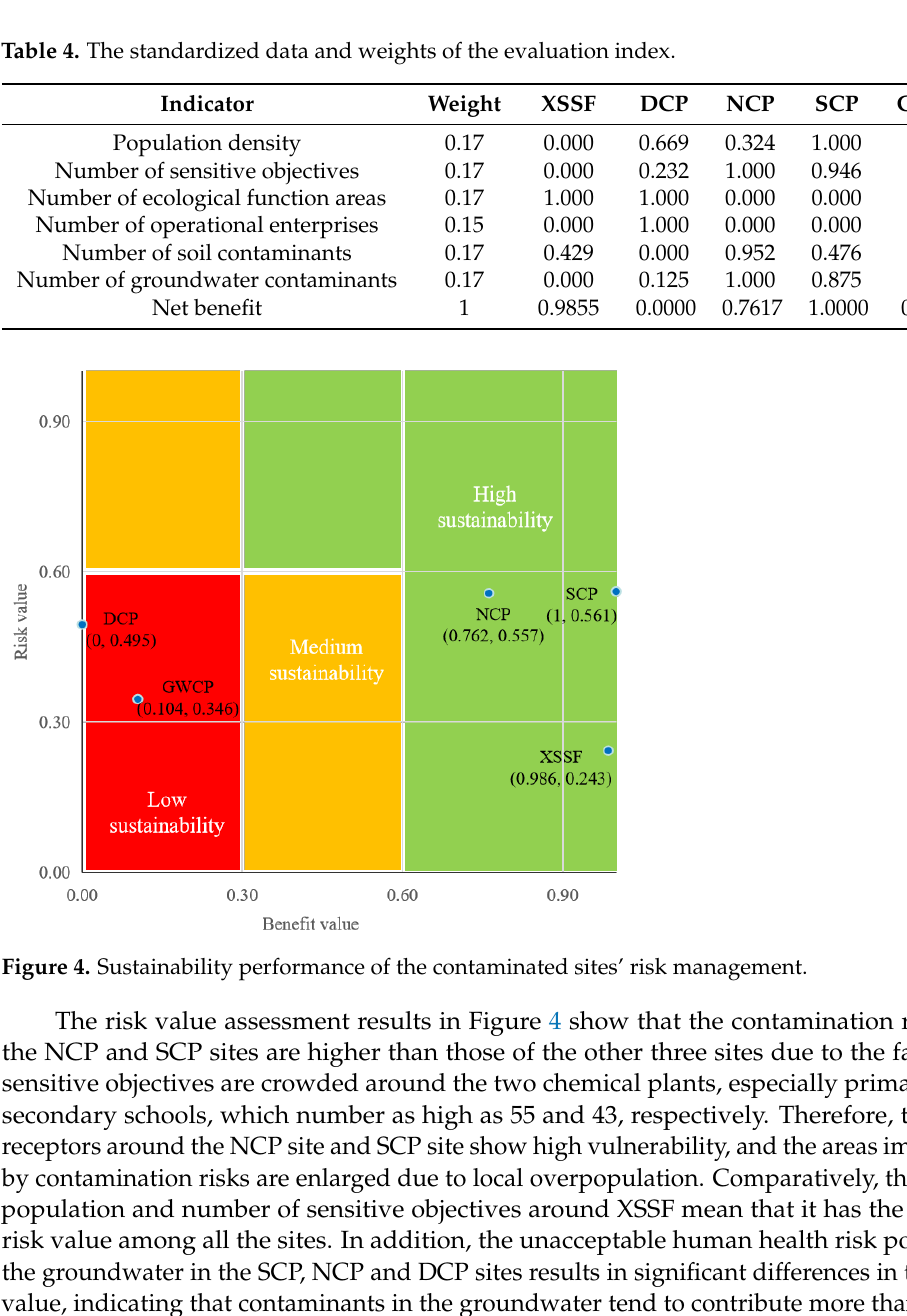
10 of 13 Table 4. The standardized data and weights of the evaluation index. Indicator